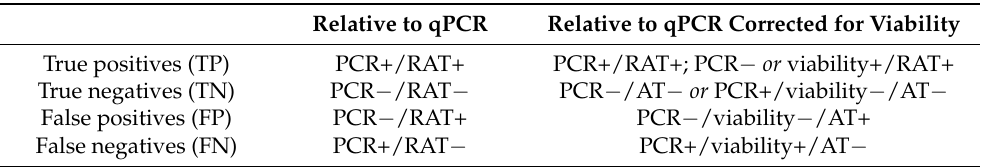
Table 1. Explanation of the calculation of test result values without and with correction on viability; + = positive; − = negative. Relative to qPCR Relative to qPCR Corrected for Viability True positives (TP) PCR+/RAT+ PCR+/RAT+; PCR − or